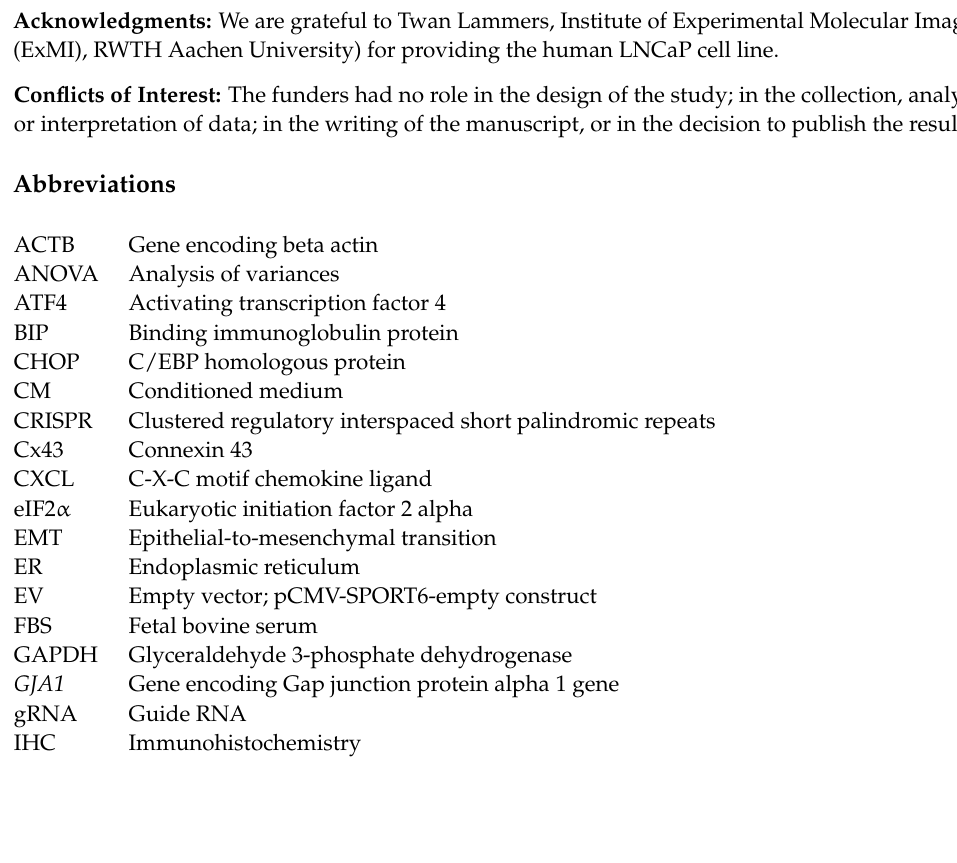
prostate tissue, Table S1: Human primers used for RT-qPCR, Table S2: Primary and secondary antibodies used in Western blot analysis, Table S3: Reported LCN2 mutations in studies deposited in the TCGA